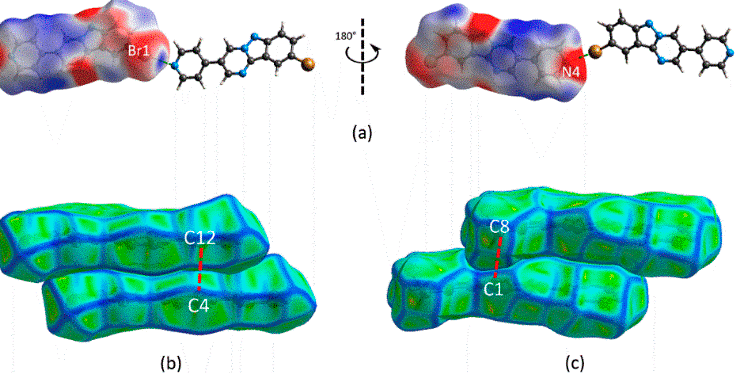
Figure 5. Hirshfeld surfaces mapped with ( a ) electrostatic potential for 1b (property range: − 0.0225 to − 0.0528 Hartree atomic units), showing the charge-induced interaction between the electron-deficient site of Br1 at the sigma hole and negative site of the pyridyl ring. Hirshfeld surfaces mapped with curvedness (property range: − 4.0 to +0.4 arbitrary units), showing the shape complementarity between the stacking of pyrimido[1,2- b ]indazole fused rings connected through ( b ) C4···C12 for 1b and ( c ) C1···C8 for 1c .